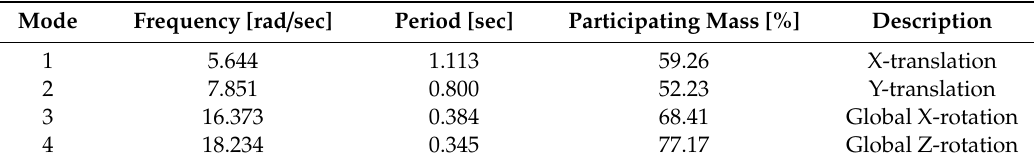
Table 2. Masonry